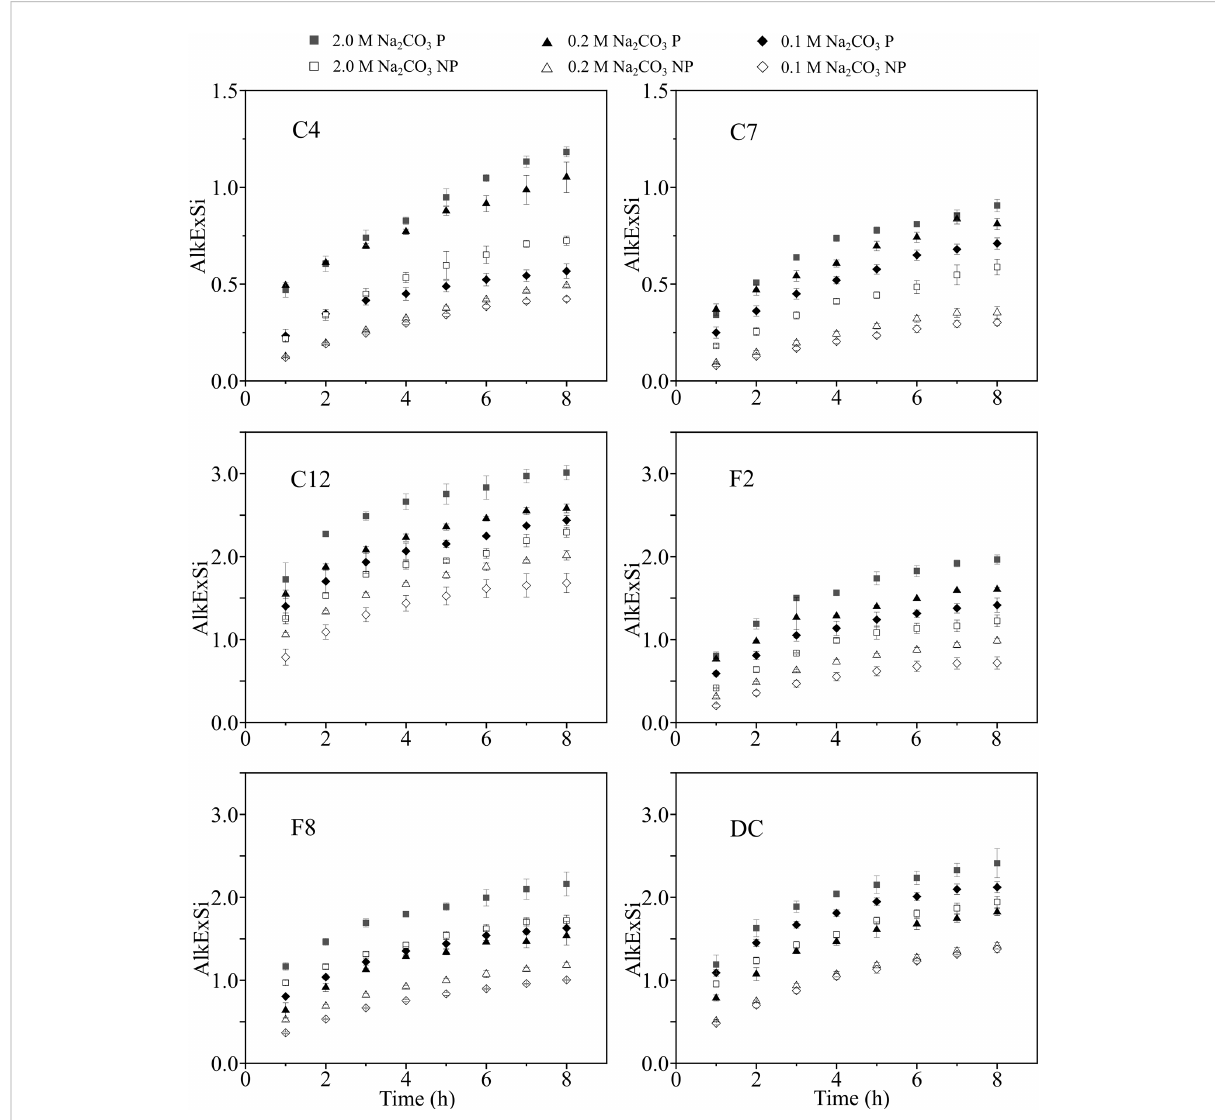
FIGURE 3 Conventional wet alkaline digestion using Na 2 CO 3 (0.1 M, 0.2 M and 2.0 M; P vs. NP) solution. A subsample was removed at each 1 h with a total extraction of 8 h. The alkaline extracted silica content (SiO 2 %) was normalized into the dry weight of the sediment. P represents pretreatment of sediment using HCl (1.0 M) and H 2 O 2 (10%) before digestion; NP represents no pretreatment before alkaline digestion. The error bars were averaged from triplicate digestions. The locations of samples C4, C7, C12, F2, F8, and DC are shown in Figure